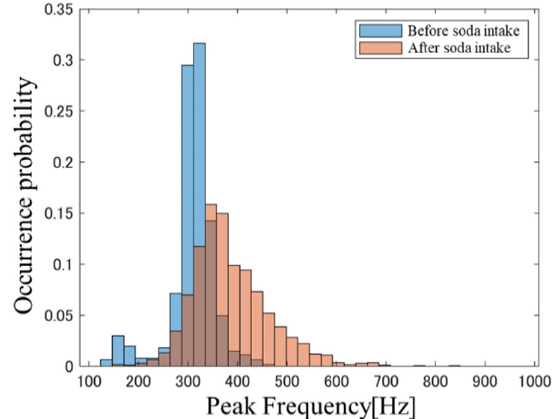
Figure 1. PFH before and after carbonated water intake.